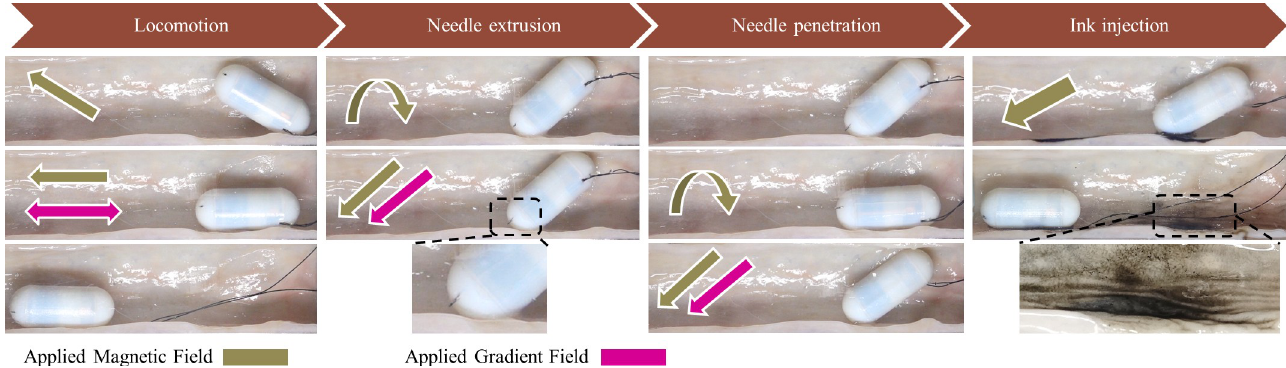
Fig 14. Ex-vivo experimental results conducted in pig’s small intestine with four steps of the TCE procedure. The arrow shows the direction of the vector; the straight arrow represents the non-rotating magnetic field and the rotation arrow represents the rotating magnetic field.